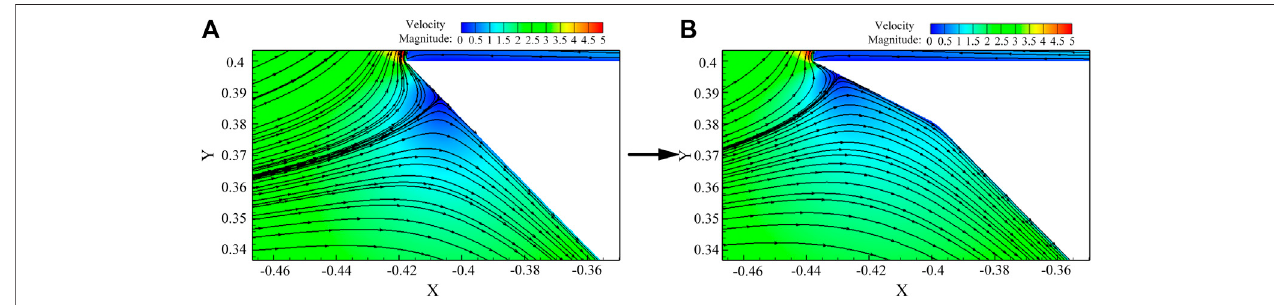
FIGURE 5 | Flow at the upper edge of the